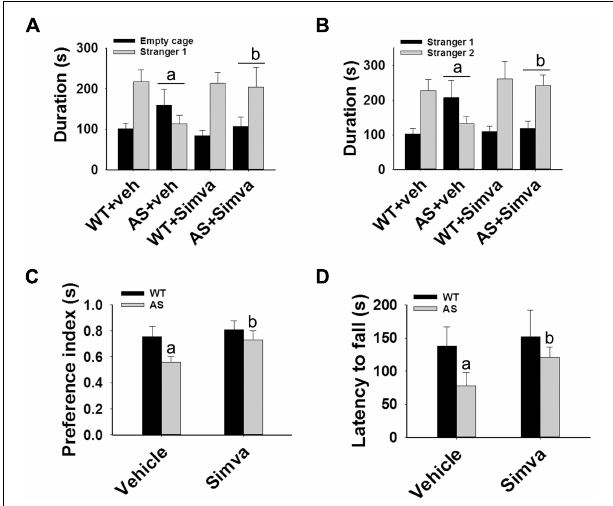
FIGURE 7 | Oral administration of simvastatin enhances social interaction, improves memory deficit and motor coordination in AS mice. Wild type and AS mice were orally given either vehicle (DMSO) or simvastatin (1 mg/kg body weight) for 60 days. Behavioral tests were performed between 45 and 55 days of simvastatin treatment. (A,B) Test for social interaction displaying significant enhancement of sociability (A) and social novelty (B) in AS mice in response to simvastatin. (C) Novel object recognition test showing significant increase in the preference for the novel object in AS mice upon drug exposure. (D) Motor coordination test. Values are mean ± SD with 10 animals in each group. The “a” indicate P < 0.05 compared to vehicle treated wild type group whereas “b” denote P < 0.01 compared to vehicle treated AS mice group. Data was analyzed by two-way (A,B) or one-way (C,D) ANOVA with Holm–Sidak post hoc test.